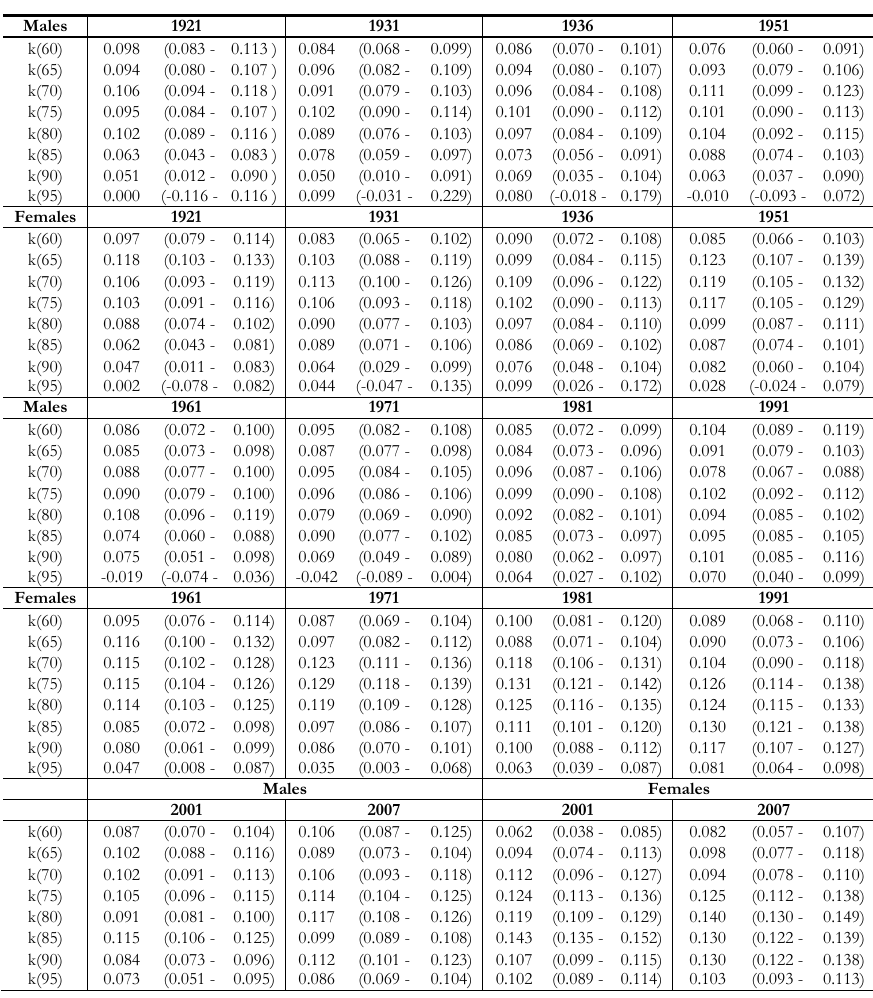
Estimates of k(x) (95% CI) in the period 1871-2007 (continued)